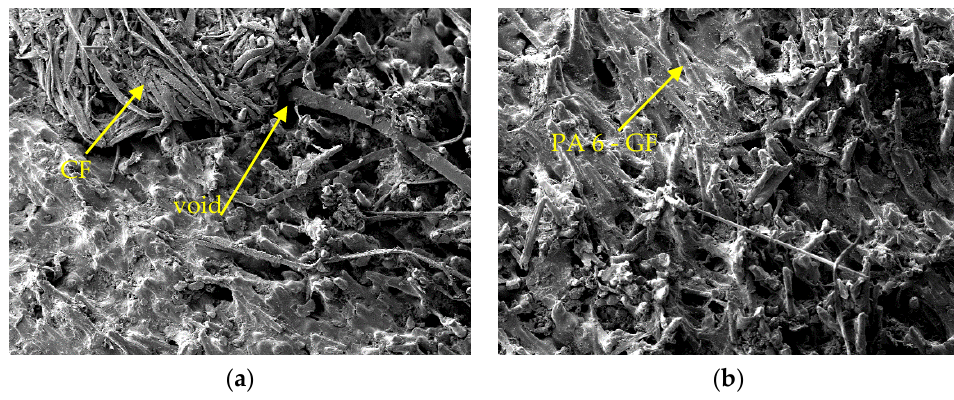
Figure 6. Micrograph of fracture surface: ( a ) low impact resistance specimen; ( b ) high impact resistance specimen.